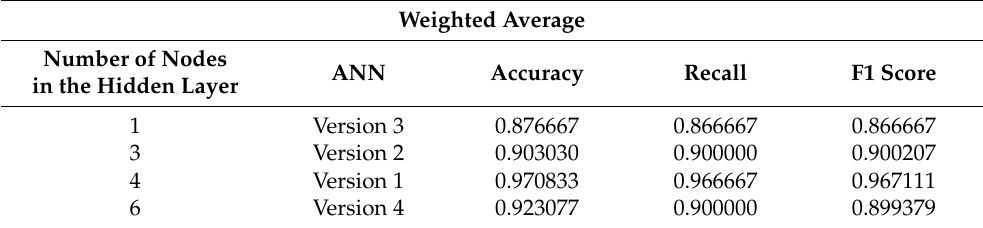
Table 7. Classification metrics for the target variables of each analyzed